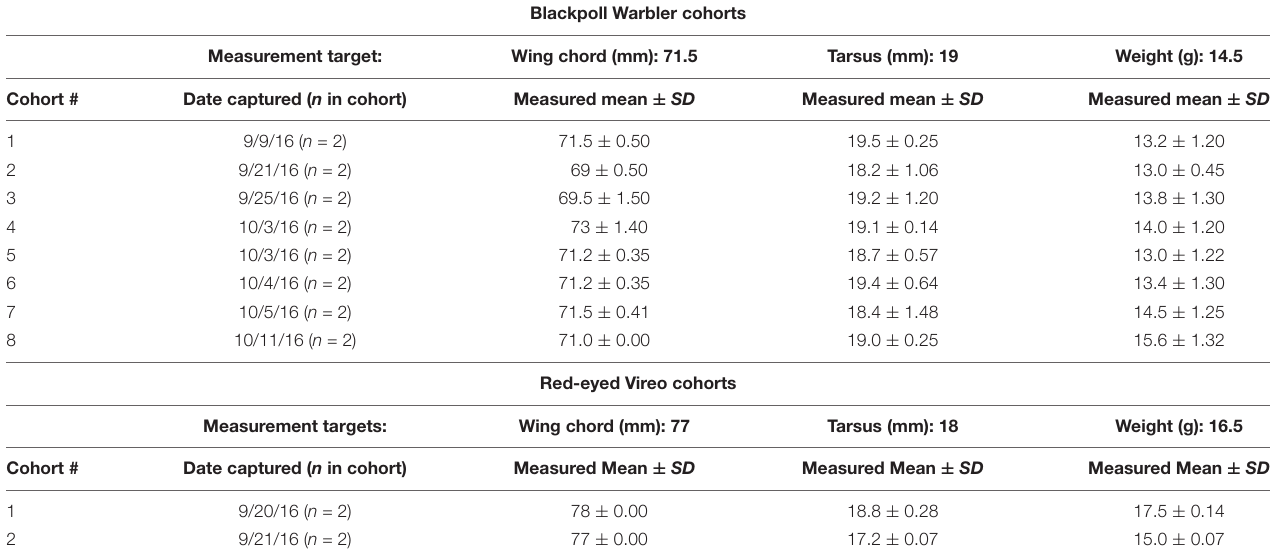
TABLE 2 | Target parameters used to select which individuals at capture could be included in each cohort per species and the measured values (mean ± SD ) of these parameters, number of individuals included and the date of capture for each cohort. Blackpoll Warbler cohorts Measurement